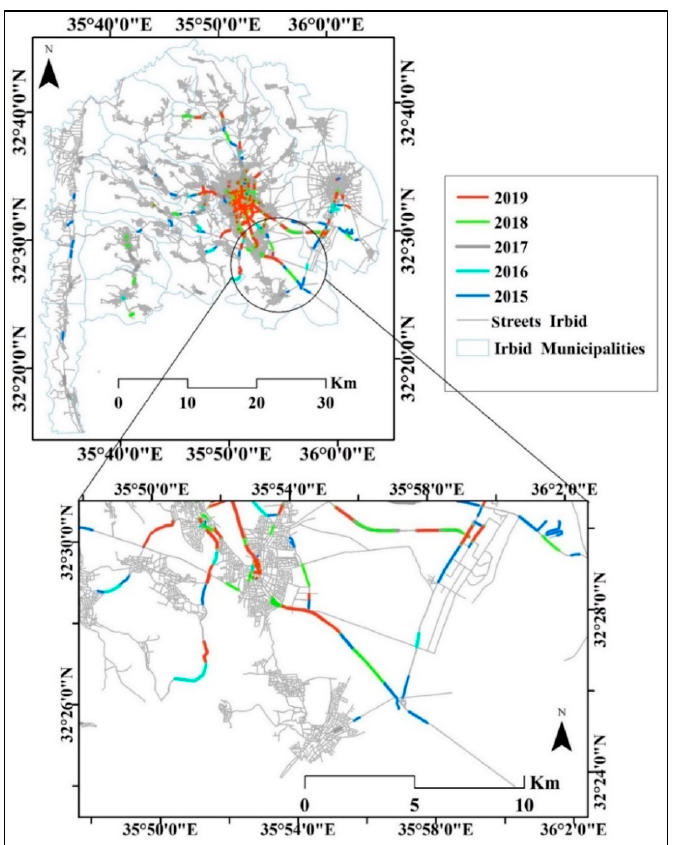
Figure 8. Composite spatiotemporal geographic distribution map of traffic-accident hotspots at the year level from 2015–2019.